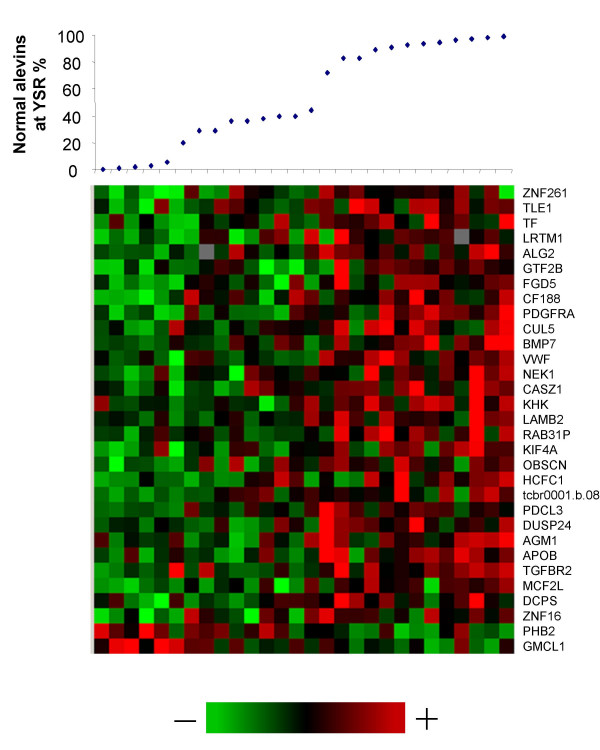
Supervised average linkage clustering analysis of 31 genes significantly linked to egg quality. Each row represents a gene and each column represents an egg RNA sample. The 31 samples are supervised according to the percentage of normal alevins at yolk-sac resorption. For each gene, the expression level within the sample set is indicated using a color intensity scale. Red and green are used for over and under abundance respectively while black is used for median abundance.